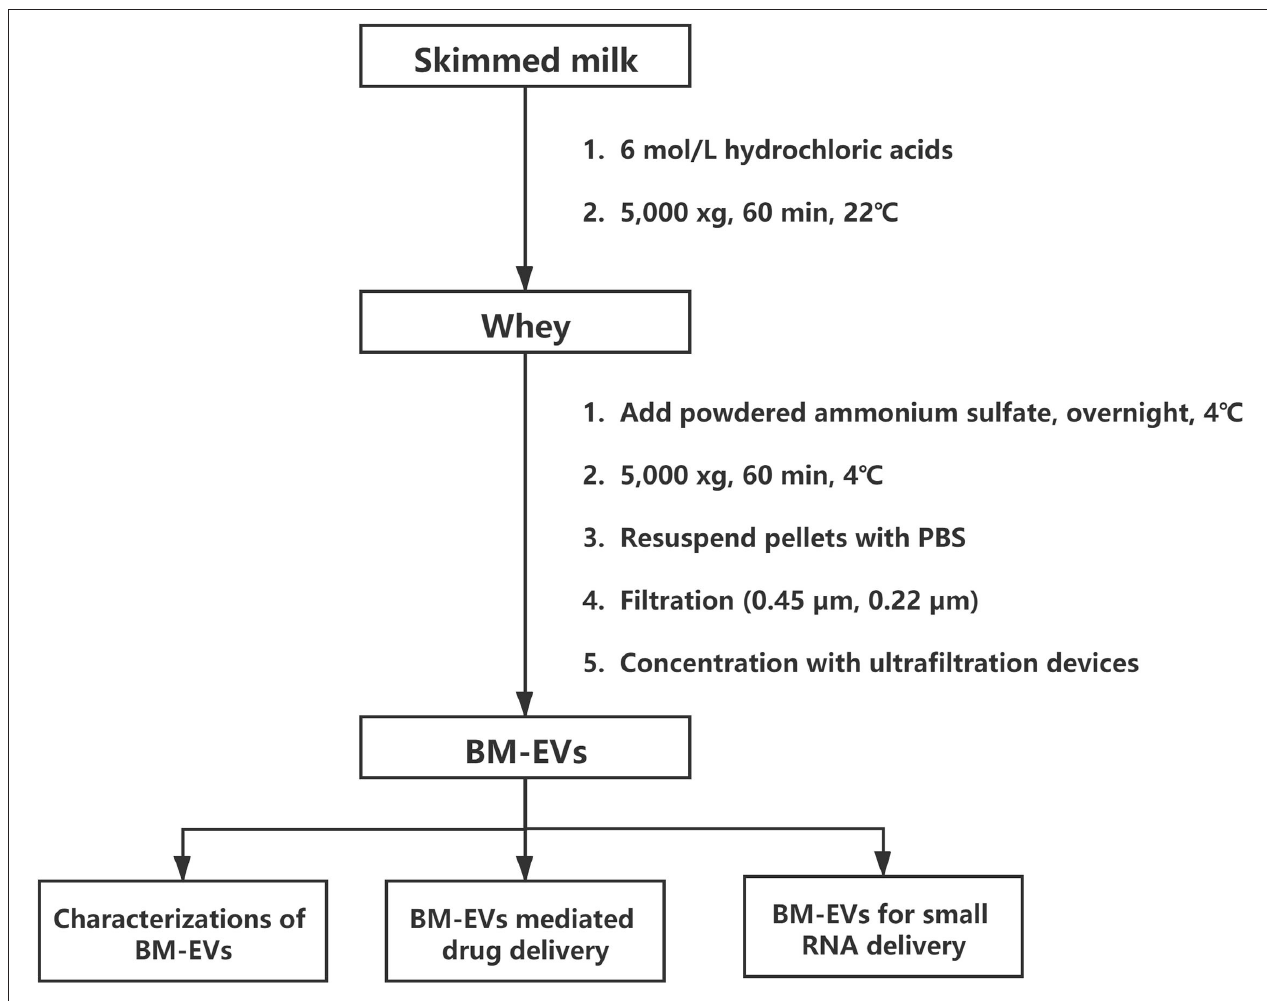
FIGURE 1 | Flowchart of isolating BM-EVs with ammonium